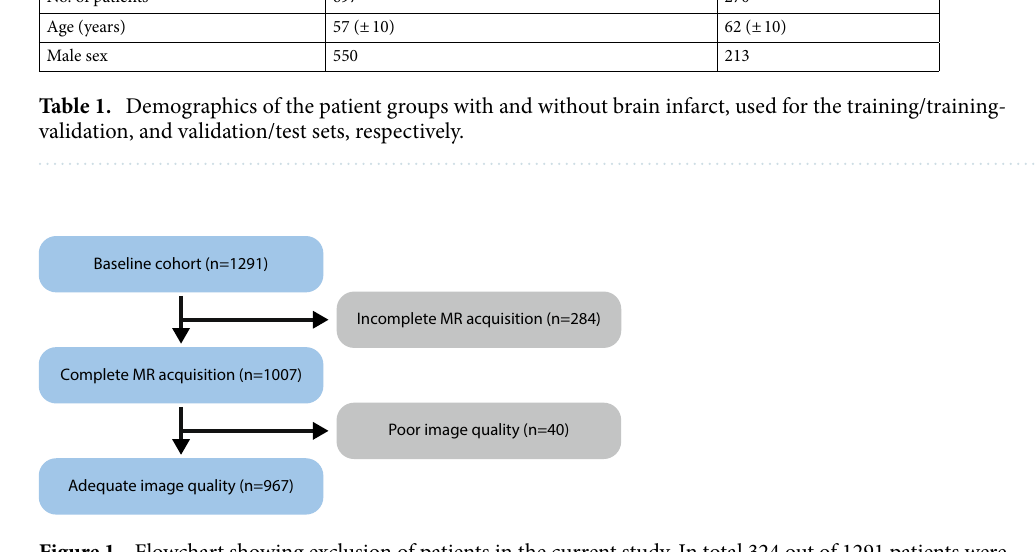
Figure 1. Flowchart showing exclusion of patients in the current study. In total 324 out of 1291 patients were excluded from the current study because of an incomplete MR acquisition (284), where one of two acquired MR images were missing, and because of poor image quality